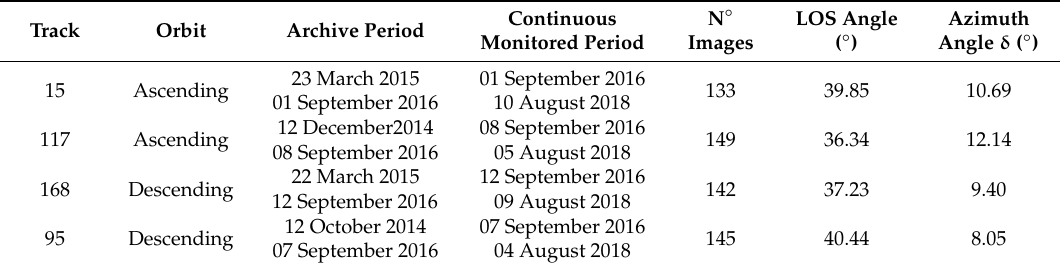
Table 1. Details of the available dataset of Sentinel-1A & B used to investigate the ground deformation in